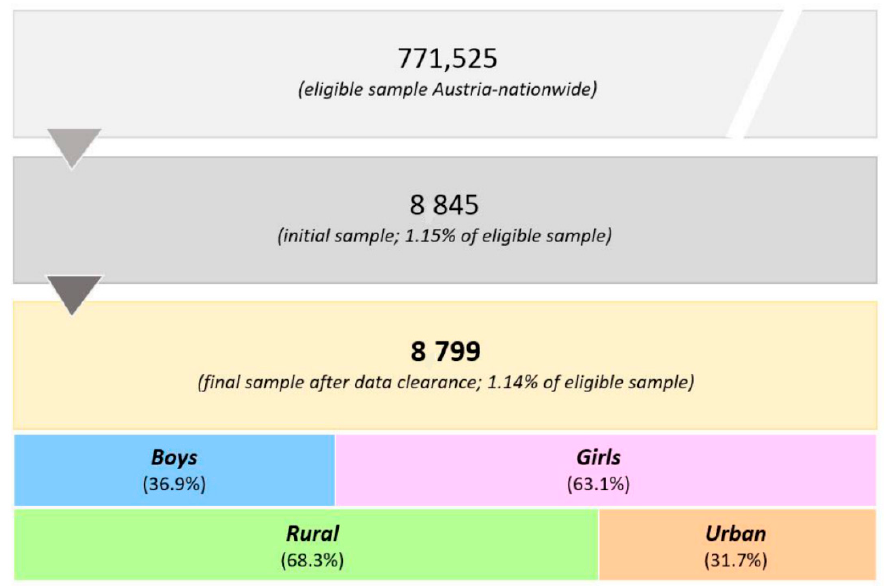
Figure 1. Flow chart of the pupils’ enrollment and classifications based on sex (boys vs. girls) and living area (rural vs. urban).